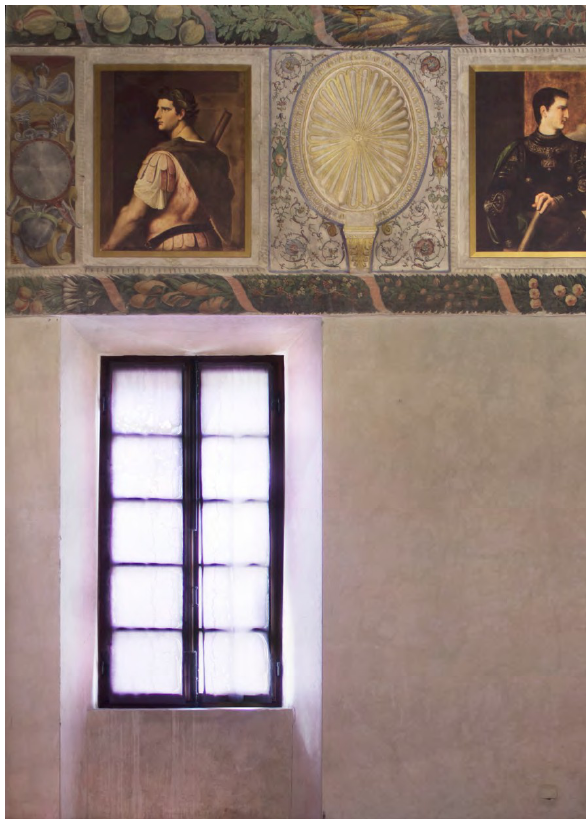
Figure 6. Details of the room coming from Photoscan projections